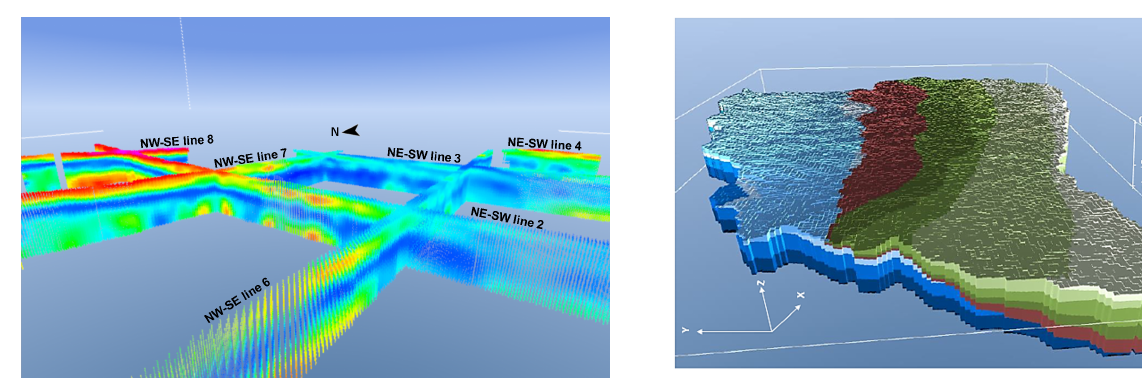
Figure 5. A 3D view of the B-field SCI results along the 20km × 20km grid lines in the study area. These soundings were used as a basis for geologic interpretation and modeling. The arrowhead points northwards. For the locations of the grid lines, see Fig. 1a.